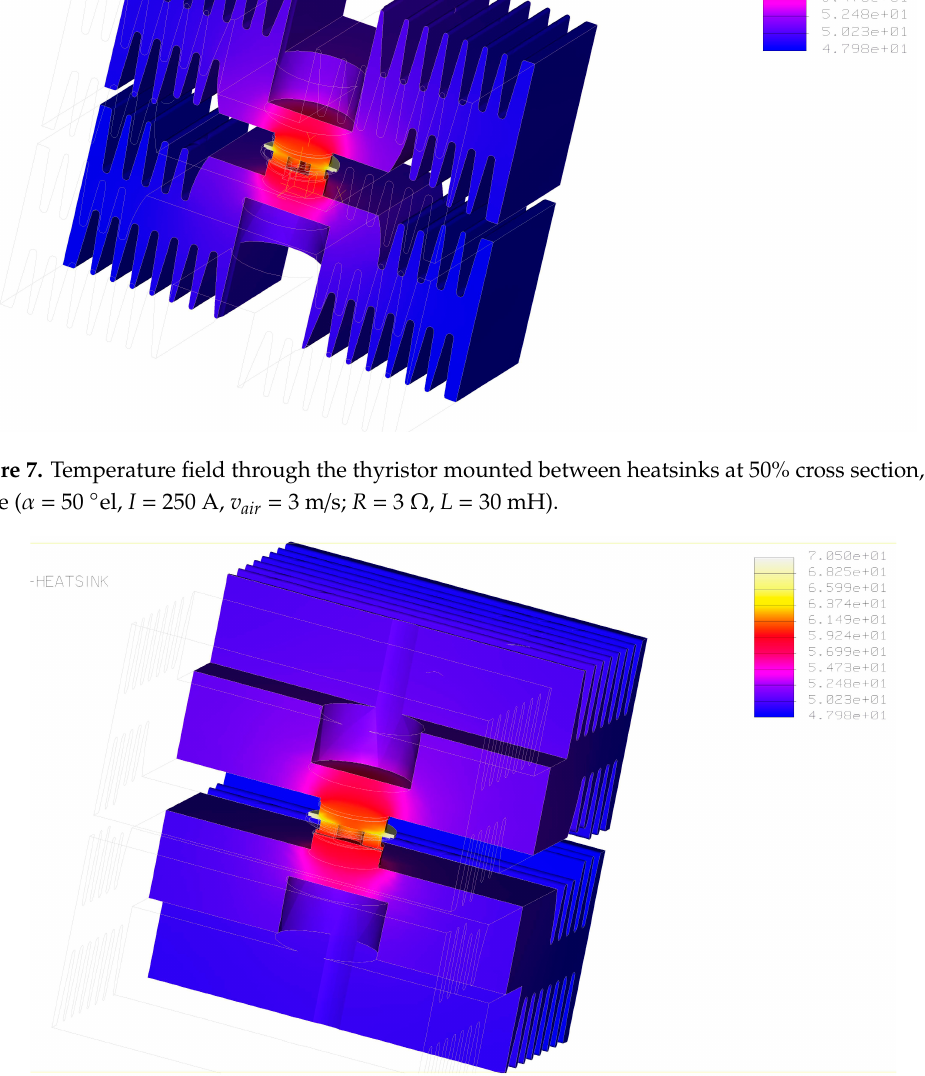
Figure 8. Temperature field through the thyristor mounted between heatsinks at 50% cross section, xz plane ( α = 50°el, I = 250 A, v air = 3 m/s; R = 3 Ω , L = 30 mH).